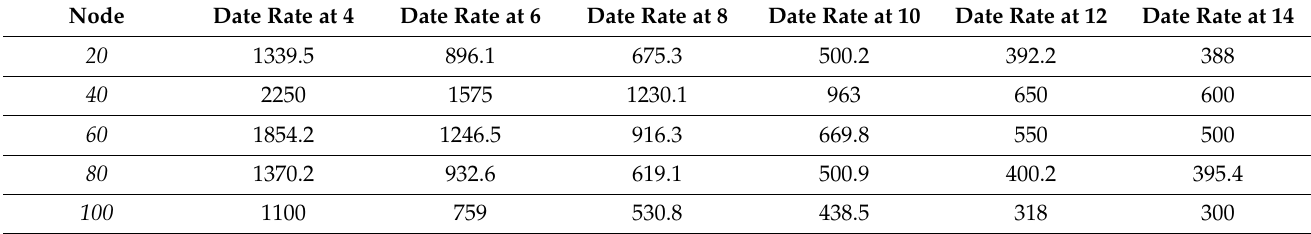
Table 5. Lifetime of network.